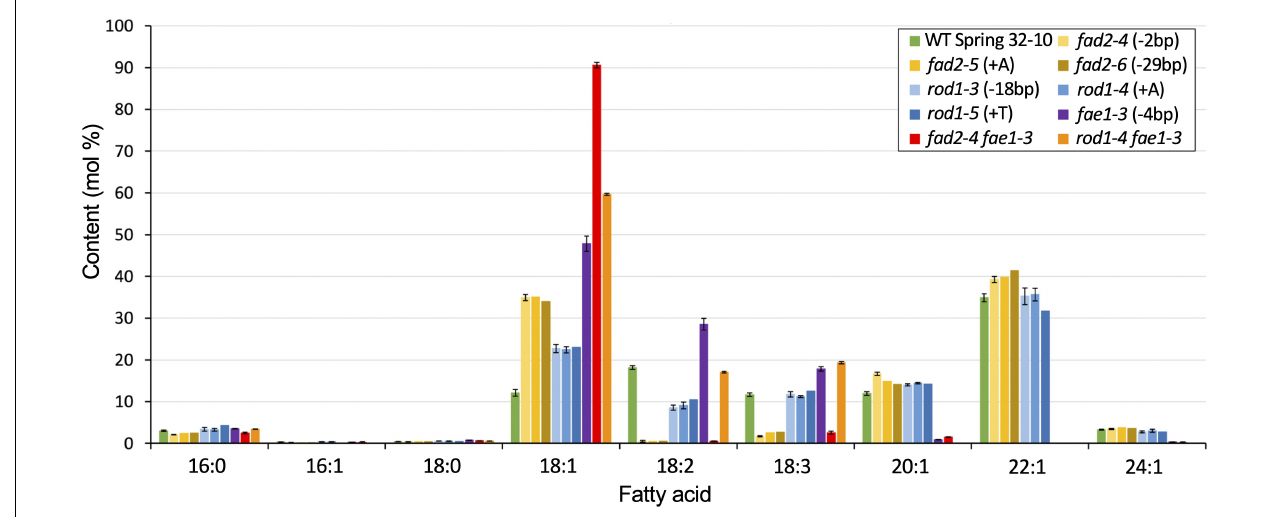
FIGURE 2 | Fatty acid composition of seed TAGs for the different lipid mutants versus WT. Graph shows mean weight percents of the different lipid species. Error bars represent standard deviations of the means where n = 2 or 3 biological reps and 3 technical reps. Those without error bars are single samples. See Supplementary Table 1 for values and statistical